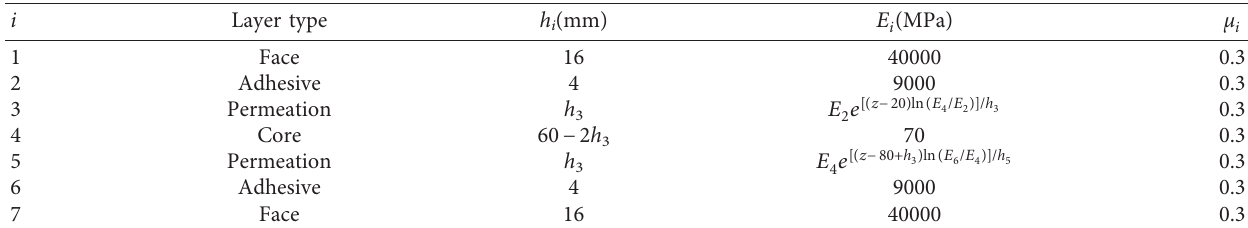
Table 5: The thickness and material properties for each layer in the sandwich arch with seven